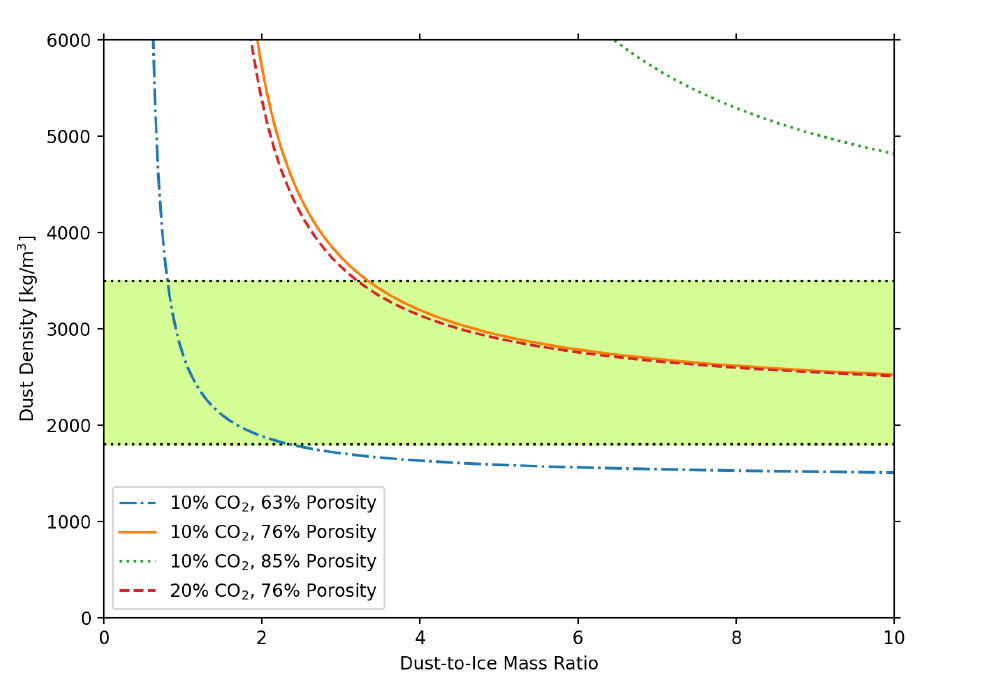
Figure 2. This plot shows the resulting dust density for varying dust-to-ice mass ratios and porosities. The green-coloured area indicates reasonable dust densities. The given CO 2 percentage corresponds to the CO 2 content of the total ice